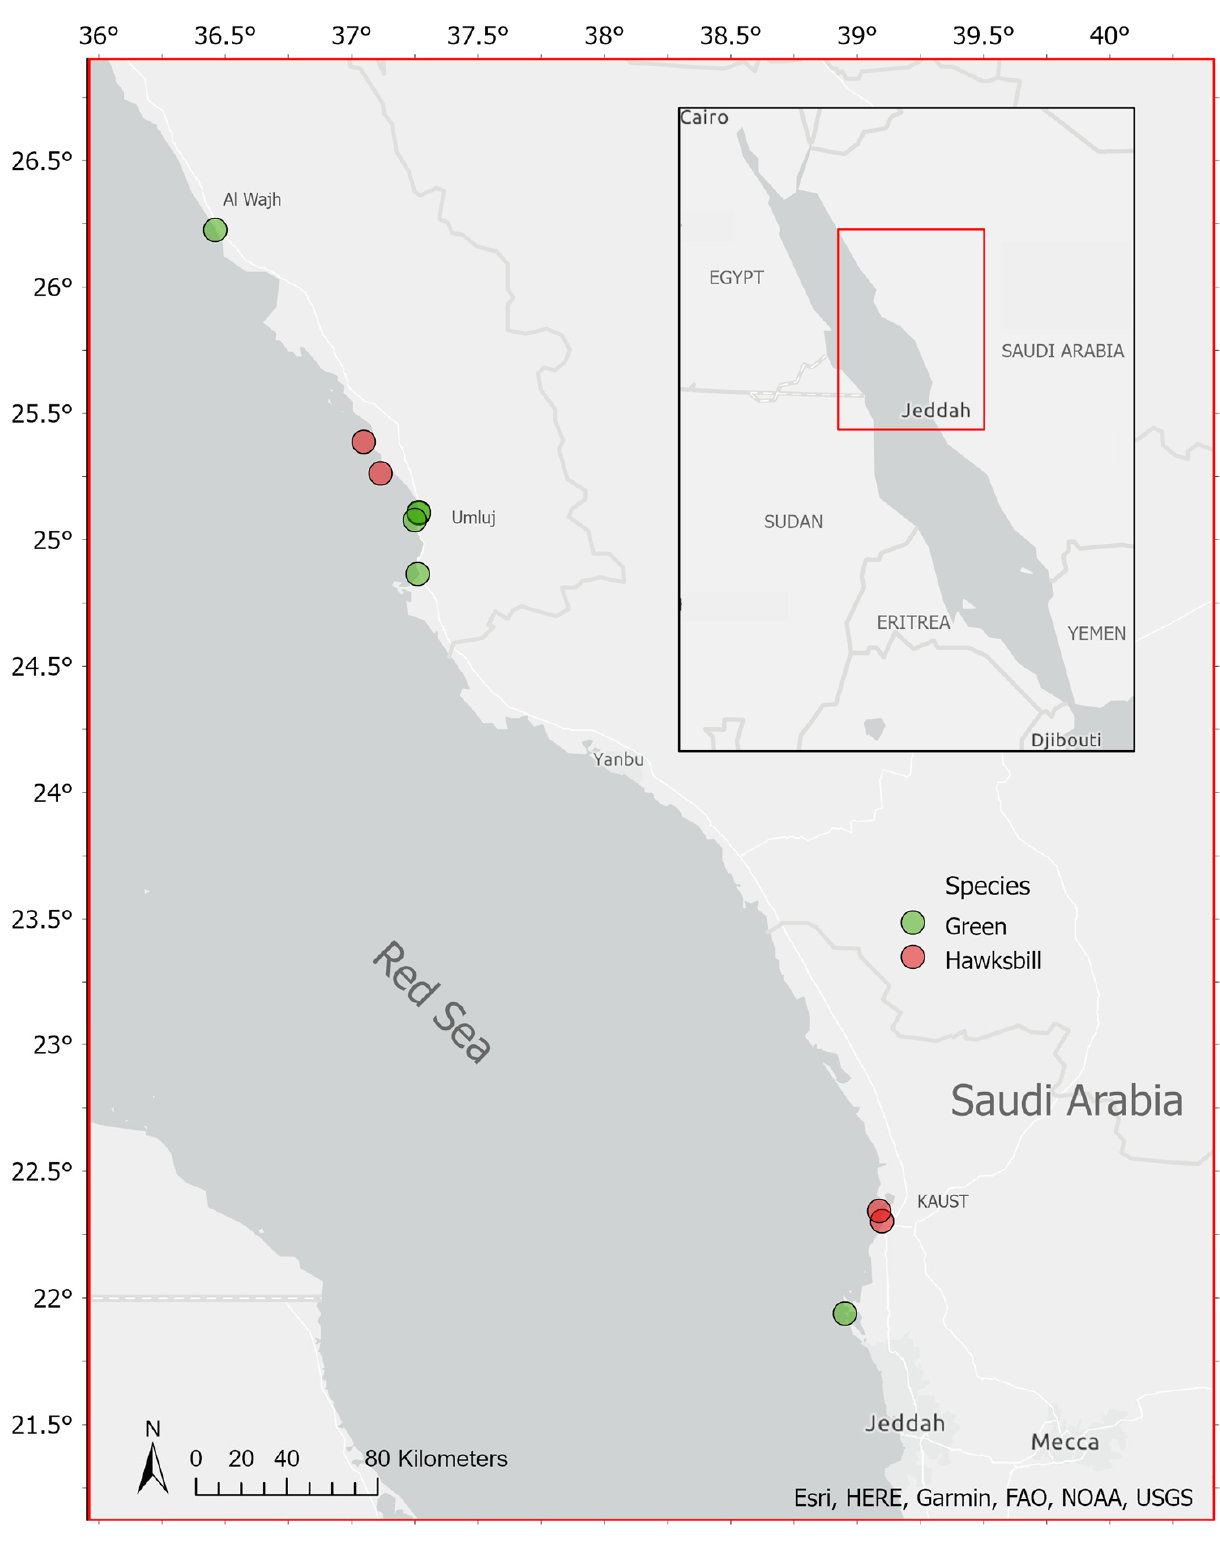
Figure 1. Locations of the stranded turtles collected along the Saudi Arabian Red Sea. Green dots represent the green turtle specimens ( Chelonia mydas ), whereas red dots represent the hawksbill turtle specimens ( Eretmochelys imbricata ).